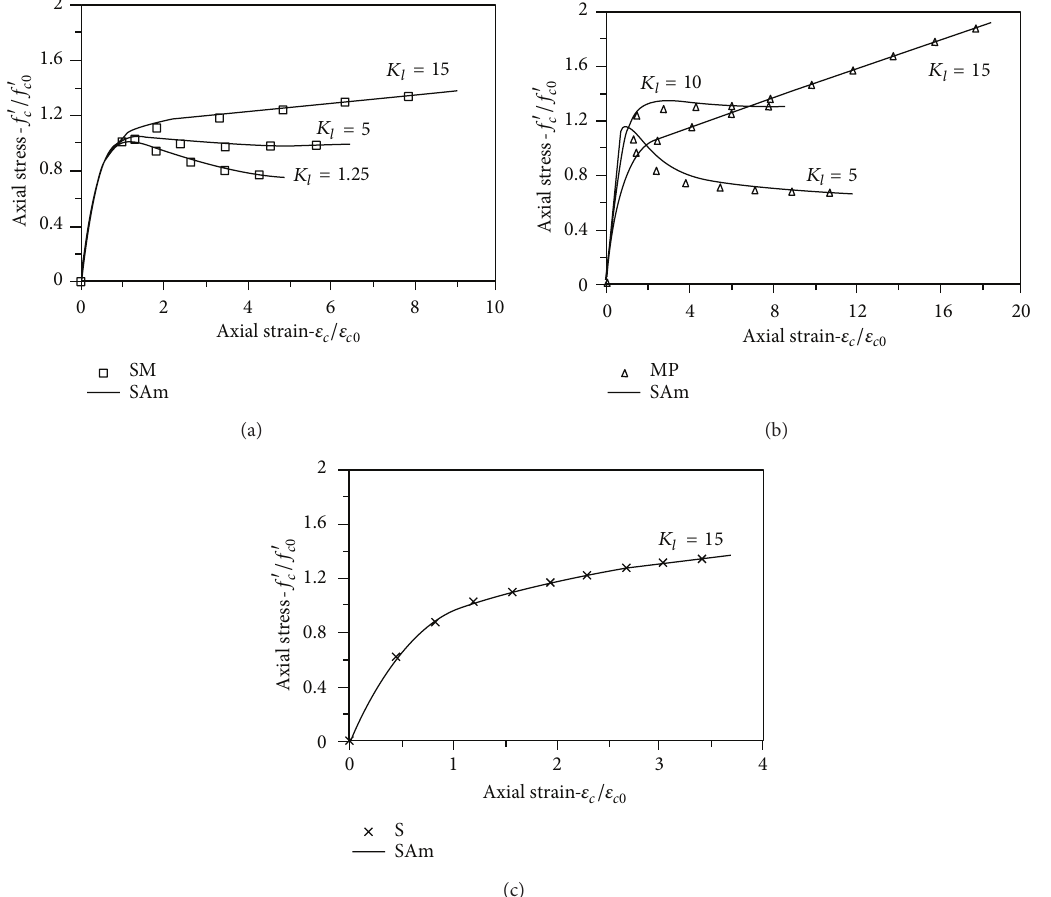
Figure 4: Stress-strain relationship: comparison of analytical results of Spoelstra and Monti [26] (a), Moran and Pantelides [25] (b), and Samaan et al. [23] (c) models with results of